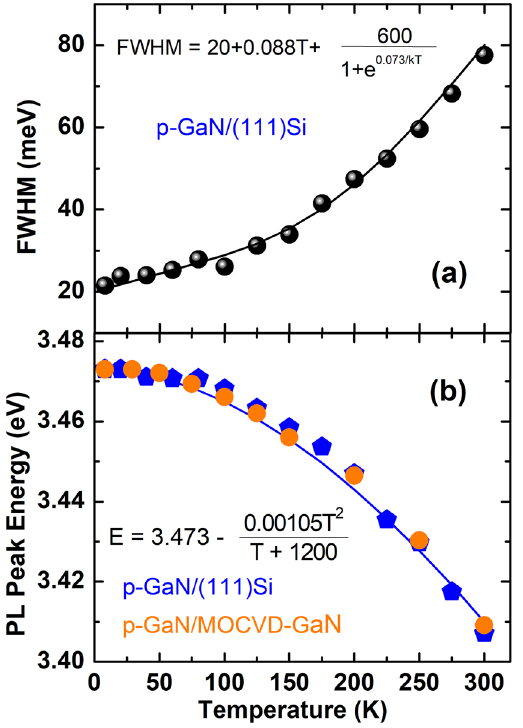
Figure 4. ( a ) Evolution of the full width at half maximum of the (FE + D 0 X)–related PL against temperature: black spheres correspond to the experiment data on p-GaN/(111)Si whilst full line is the result of the fitting. ( b ) Temperature-induced redshift of the (FE + D 0 X)-related PL: blue pentagons and orange circles denote the experimental data on p-GaN/(111)Si and p-GaN/MOCVD-GaN, respectively. The full line shows the fit using Varshni’s